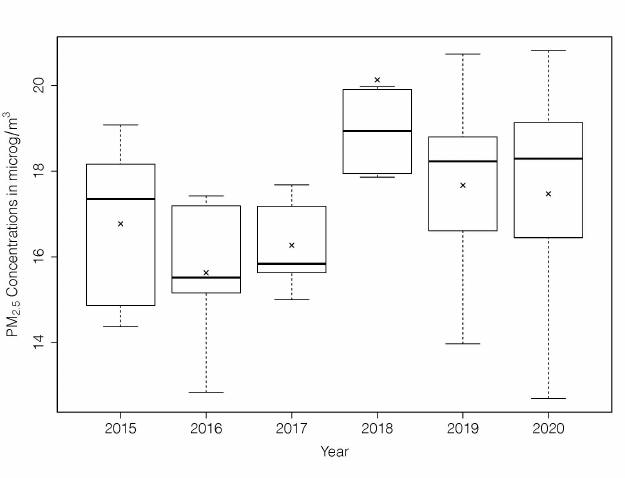
Figure 4. The NO 2 daily ground-level concentrations during May 2015–2020 measured by the selected SP ( A ) and RJ ( B ) stations.